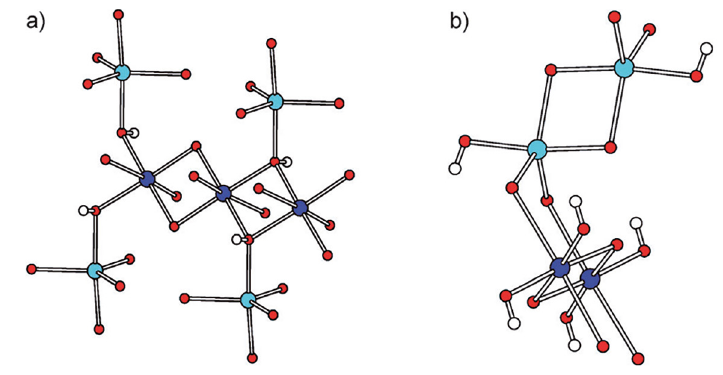
(OH) octahedra and CuO Figure S1: Views showing the corner-sharing between CuO 4 2 trigonal bipyramids in Cu (OH)PO . For CuO (OH) octahedra, O red, H white, and Cu 2 4 4 2 blue; for CuO (OH) trigonal bipyramids, Cu cyan. (a) Corner-sharing through OH groups; 4 (b) Corner-sharing through O atoms. All O atoms, except for those in the OH groups, are tetrahedra 1 . corner-shared with PO 4